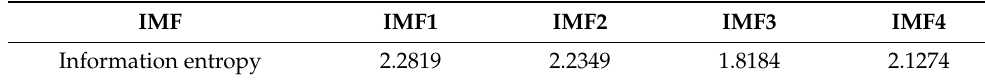
Figure 5 is the envelope spectrum analysis of IMF3 selected by information entropy.